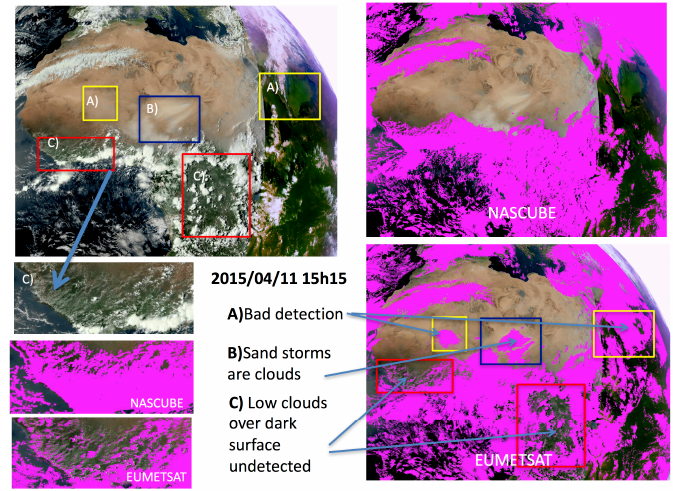
Figure 4. Comparison of NASCube EUMETSAT cloud mask products on the right hand side (highlighted in magenta) for one slot on 11 April 2015 at 15:15. On the left, several areas are drawn to highlight the deficiencies of the EUMETSAT cloud mask detection: ( A ) two areas (yellow rectangles) showing erroneous cloud detections; ( B ) one area (blue rectangle) showing that EUMETSAT assigns sandstorms as clouds; and ( C ) two areas (red rectangles) illustrating the failure of EUMETSAT cloud mask in detecting low clouds over dark surfaces.